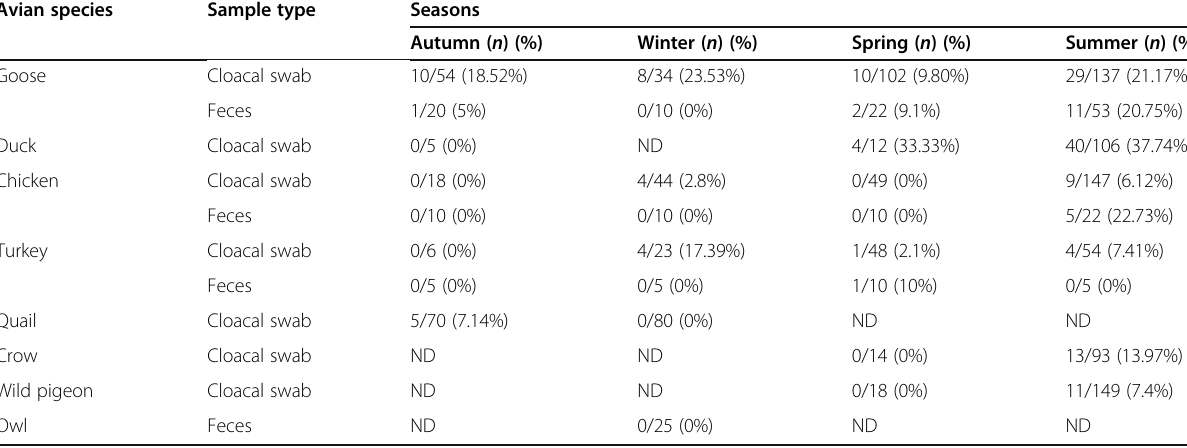
Table 2 Seasonal isolation rate ( n , %) of Arcobacter spp. from cloacal swab and feces samples of domestic poultry and wild birds Avian